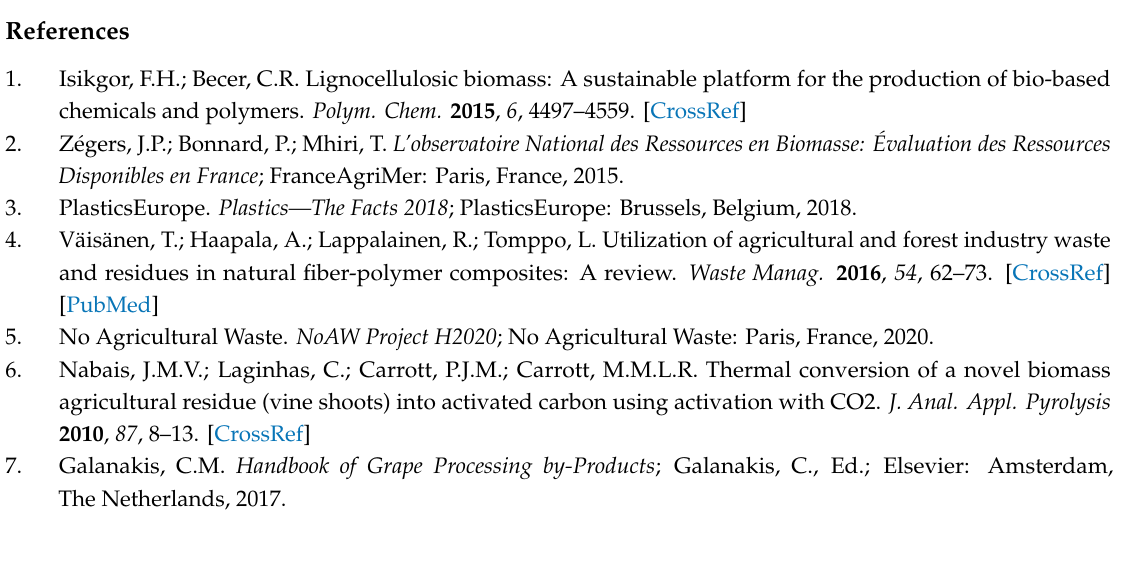
Table S1: the molecular weight data measured by gel permeation chromatography (GPC) for the indicated samples and polydispersity